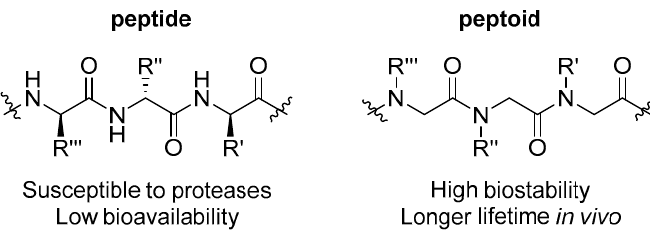
Figure 2. Representative structure of the backbone of a peptide compared to a peptoid. In peptoids, the side chain ‘R’ is moved to the nitrogen of the amide backbone, causing a substantial increase in chemical and biological stability.